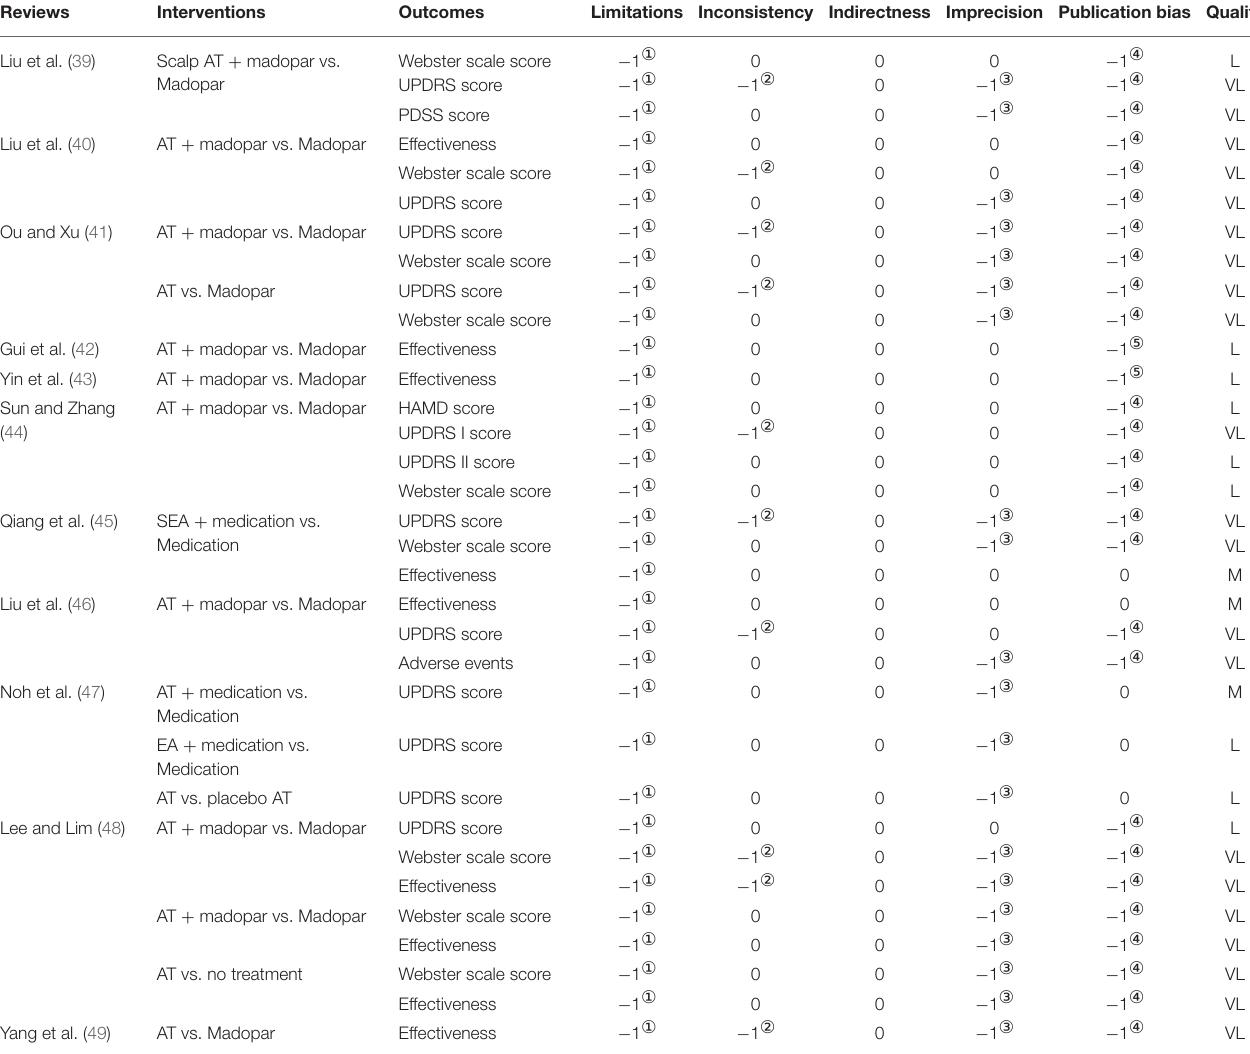
TABLE 4 | GRADE evaluation